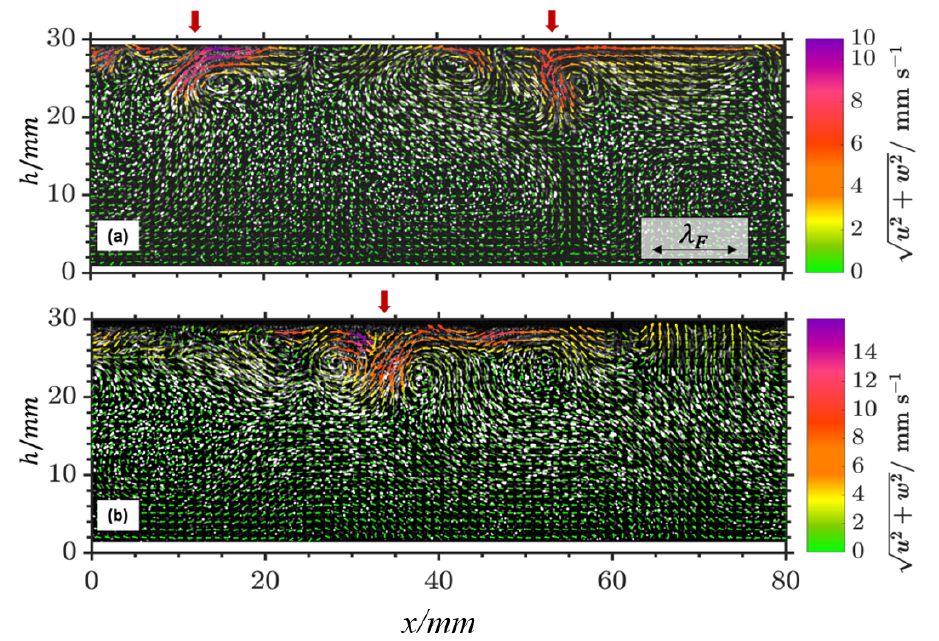
Figure 2. Instantaneous velocity field in the vertical plane on top of the corresponding particle images averaged over 16 successive images (640 ms) for a f = 0.47 g ( a ) and a f = 0.70 g ( b ). Every second arrow shown. Air–water surface at h = 30 mm. Color